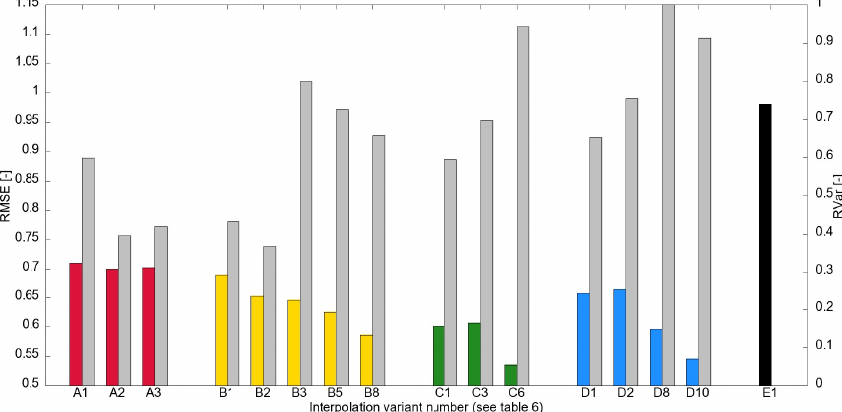
Fig. 8. Precipitation cross-validation results using all winter events averaged over time steps with average precipitation exceeding a threshold of 1mmh − 1 for selected interpolation methods (red bars: univariate methods; yellow bars: KED without radar; green bars: KED with radar reflectivities; blue bars: KED with radar rainfall intensities; grey bars: RVar coefficient; black bar: radar rainfall intensities